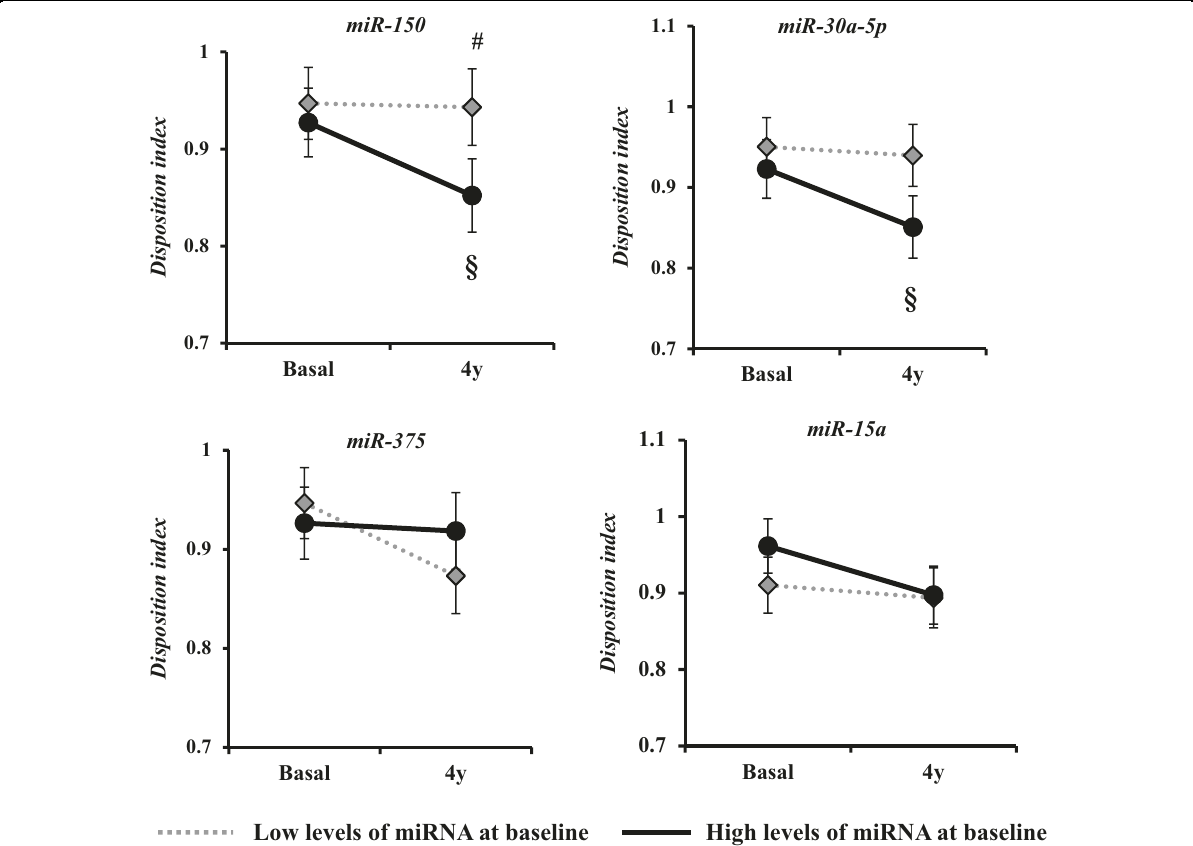
Fig. 2 Disposition index changes according to median levels of miRNAs. Values are expressed as the mean ± standard error. Variables were calculated by Wilcoxon test using SPSS (now PASW Statistics for Windows (version 21.0) (IBM. Chicago, Illinois)). The dotted gray line shows subjects with low levels of miRNA at baseline, and the continuous black line shows subjects with high levels of miRNA at baseline. § p < 0.05 baseline vs. 4 y. # p < 0.05 Low expression levels vs. high expression levels groups